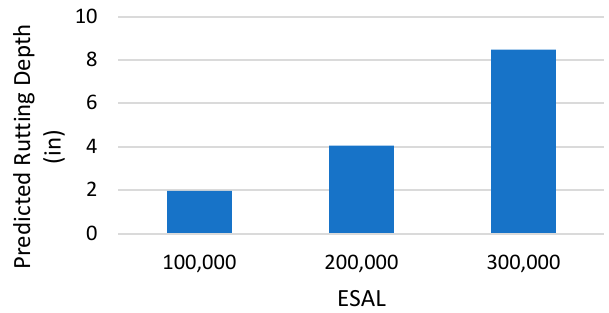
Figure 10. Model Sensitivity for ESAL.